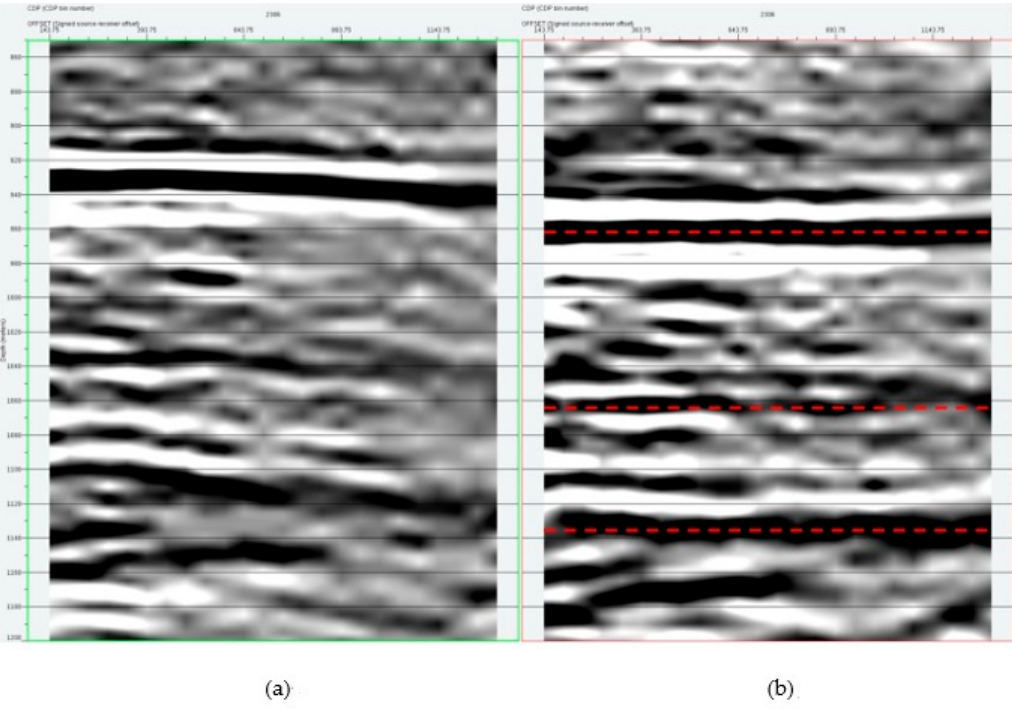
Figure 7. ( a ) CRP gather before MVA and ( b ) CRP gather after MVA at the third iteration.